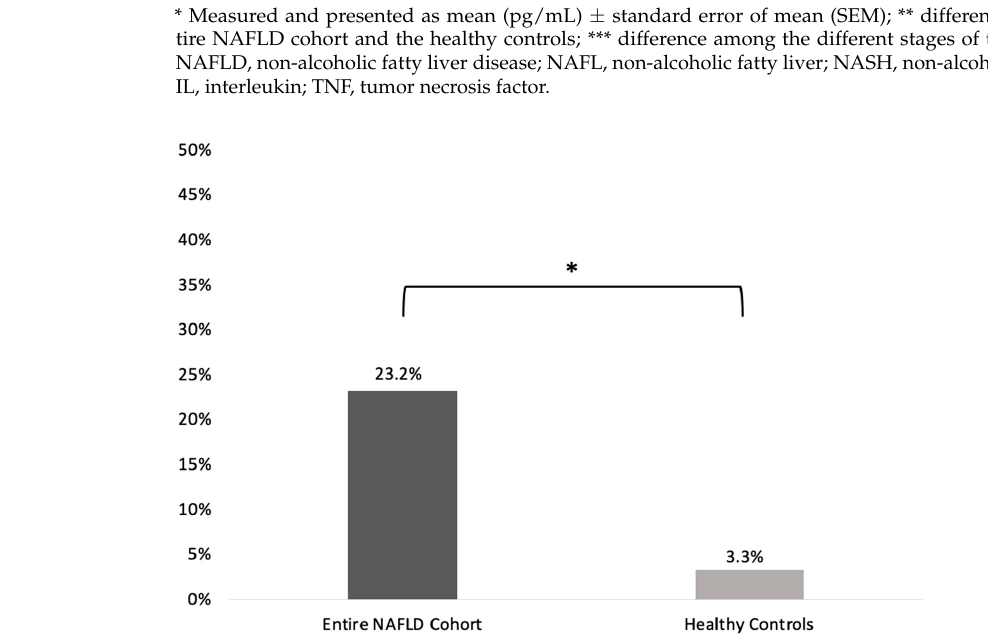
Figure 1. SIBO prevalence in the entire NAFLD cohort and the healthy controls group. SIBO: small intestinal bacterial overgrowth; NAFLD: non-alcoholic fatty liver disease. * denotes statistical significance.